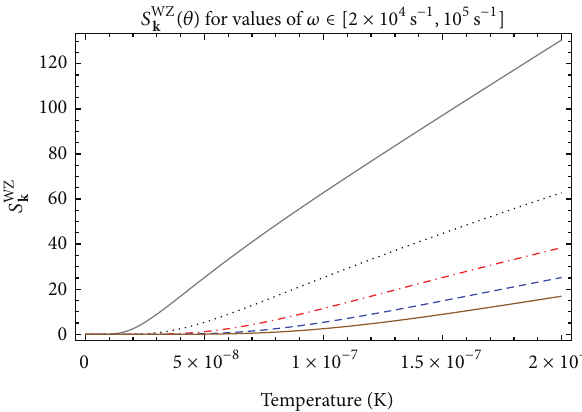
Figure 1: Plots of AAI for bosons, 𝑆 𝑃 k as a function of temperature 𝑇 , for a time interval 𝑡 = 4 × 2𝜋/𝜔 and for sample values of 𝜔 ∈ [2 × 10 4 s −1 , 10 5 s −1 ] , 𝜔 = 2 × 10 4 s −1 (gray solid line), 𝜔 = 4 × 10 4 s −1 (black dotted line), 𝜔 = 6 × 10 4 s −1 (red dot-dashed line), 𝜔 = 8×10 4 s −1 (blue dashed line), 𝜔 = 10 5 s −1 (brown solid line). We consider the massless case, and we assume that 𝑆 𝑃 k = 𝑆 𝑆 k . We neglect time dependence of 𝑇 .